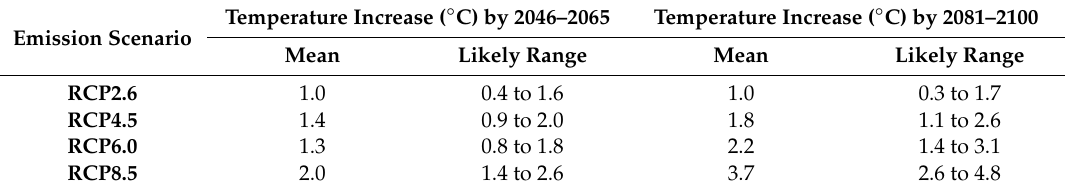
Table 1. Global warming scenarios under the Intergovernmental Panel on Climate Change (IPCC) fifth assessment report (AR5) for di ff erent emission scenarios (source: IPCC